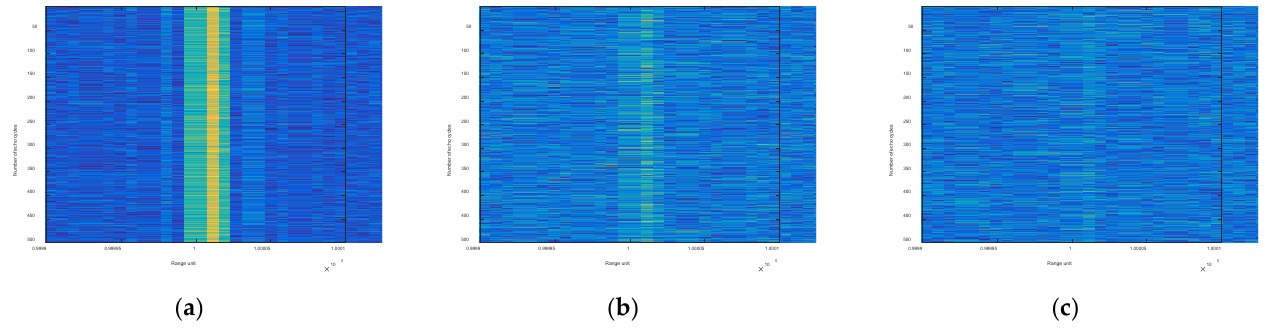
Figure 2. Two-dimensional echo sequence diagrams of 500 echo cycles under different SNR of ( a ) 12 dB, ( b ) 0 dB, ( c ) − 5 dB.